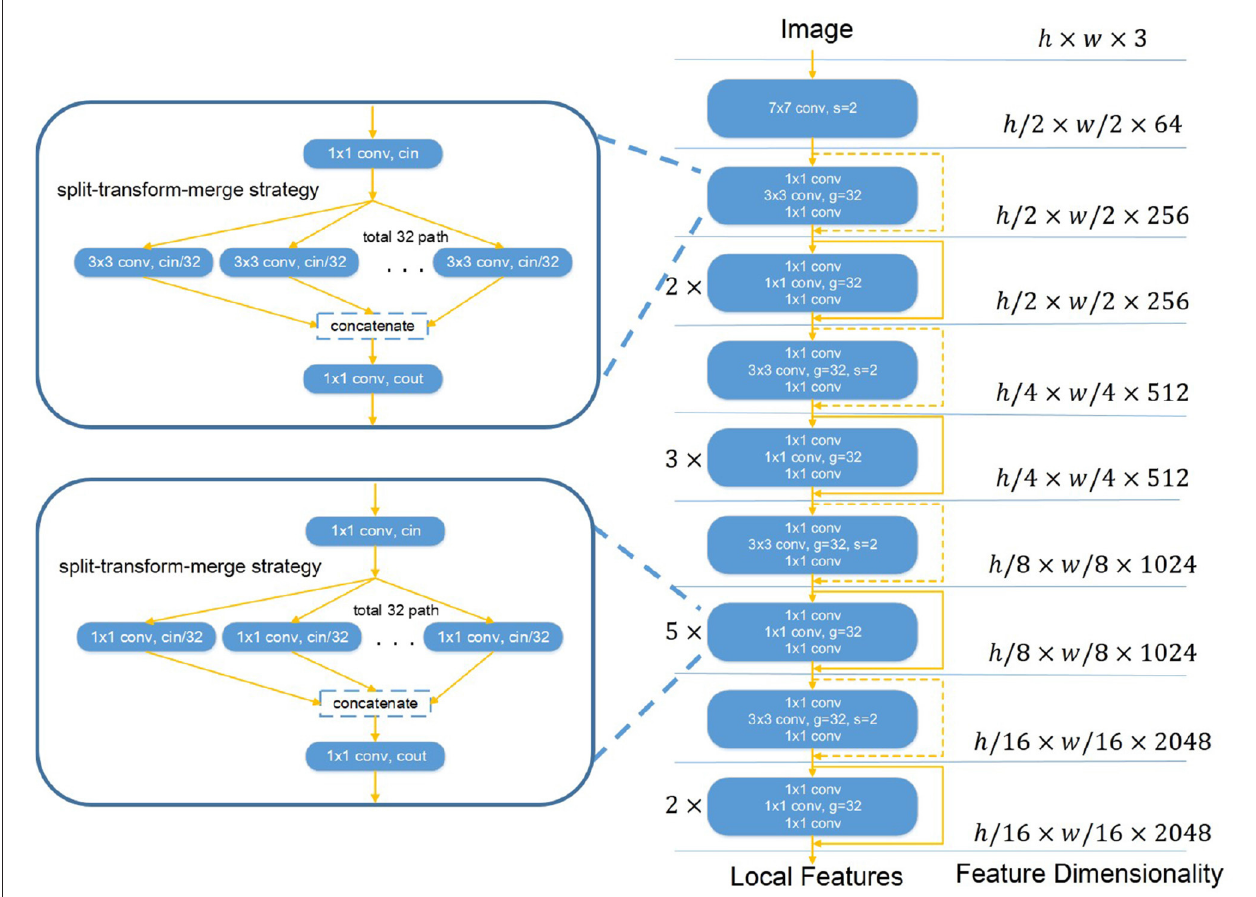
FIGURE 2 | The overall structure of Restricted ResNeXt. Restricted ResNeXt is a variant of ResNeXt architecture. The modification is mainly in the replacement of many 3 × 3 by 1 × 1 convolutions. Moreover, Restricted ResNeXt addresses the gradient vanish problem with the residual learning and reduces the model complexity with the split-transform-merge strategy. 7 × 7 conv denotes the 7 × 7 convolution layer. 1 × 1 conv denotes the 1 × 1 convolution layer. 3 × 3 conv denotes the 3 × 3 convolution layer. s and g denote the stride and group number of the convolution layer, respectively. cin and cout in the split-transform-merge block denote the channel numbers of its